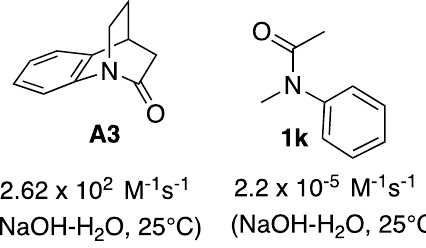
Figure 3. Model molecules used by Brown in his comparative kinetics study.